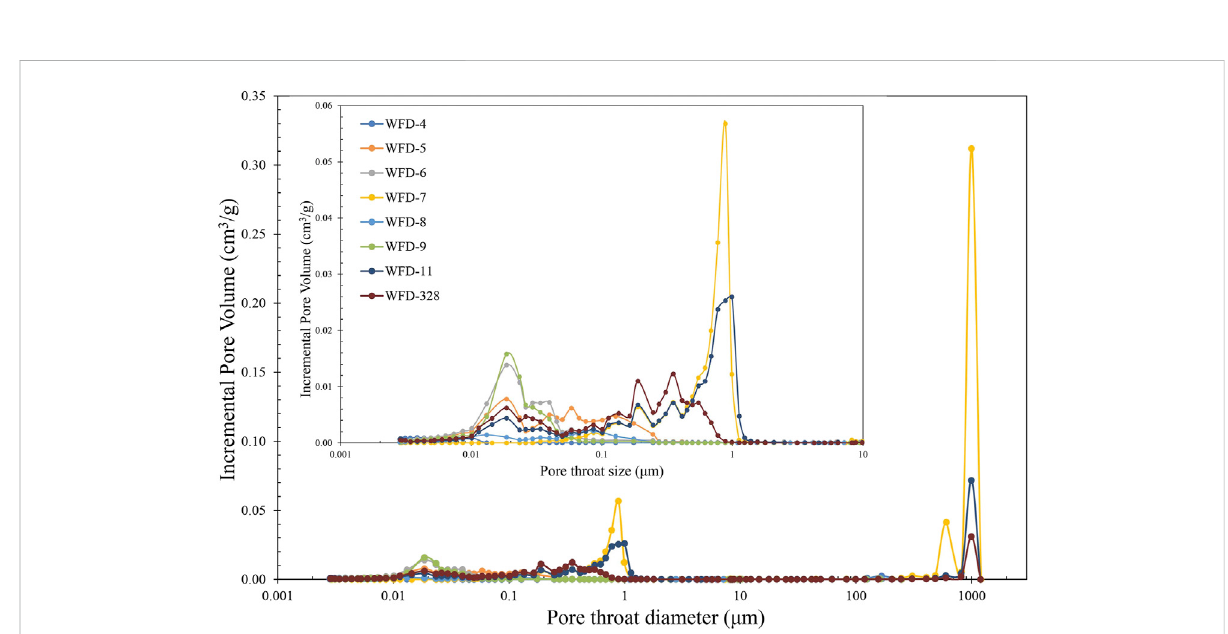
FIGURE 3 Pore-throat size distribution from MIP analyses with complete (0.3 nm-1000 µm) and zoomed (0.3 nm-2 µm) regions.